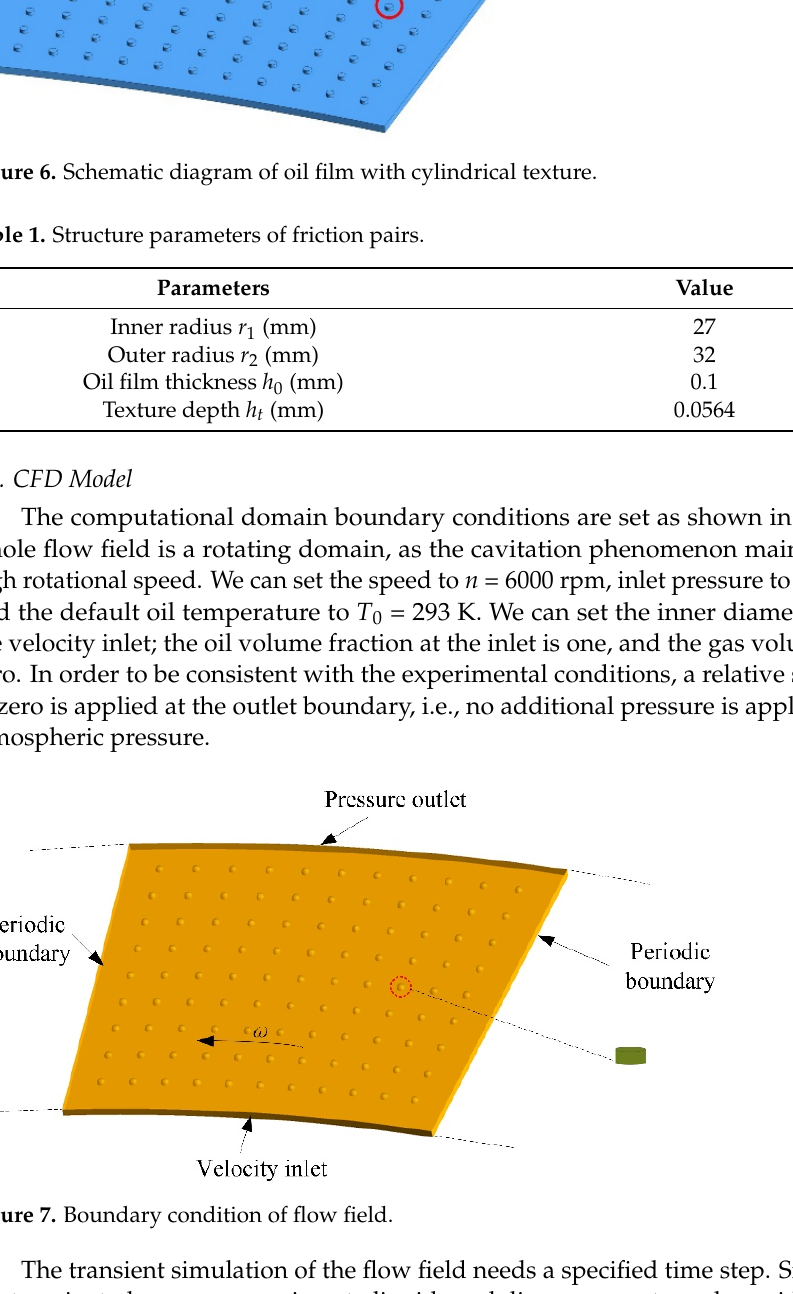
Figure 8. Structural grid of oil film. When numerical calculation is based on the finite volume method, the mesh nodes are the objects of numerical calculation, so the mesh quality directly affects the calculation accuracy and time. To test the influence of grid division quality on the accuracy of calcu- lation results, different grid-division schemes were selected. The total volume fraction of cavitation of a single oil film under default operating conditions was calculated using the CFX steady-state simulation method; the results are shown in Table 2. It is worth noting that in this study, steady-state simulations were used to verify grid independence, while a transient simulation strategy was used to simulate the cavitation process. During the simulation, the results of the transient and steady-state simulations were compared for time-saving purposes, and it was discovered that the steady-state simulation was effective in verifying grid independence. Schemes 1–3 utilize numerous axially divided layers, Schemes 2–5 utilize various cir- cumferentially divided layers, and Schemes 4–7 employ different radially divided layers. The results show that increasing the number of axial layers too much causes simulation divergence, and the inaccuracy of the calculation results corresponding to different cir- cumferential layer divisions was smaller. The selected meshing parameters in this paper are as follows: 121 layers in the weav- ing region, 124 layers in the non-weaving region, and 11 layers in the O-grid, and eventu- ally the total number of elements in the mesh division was 1,607,374.